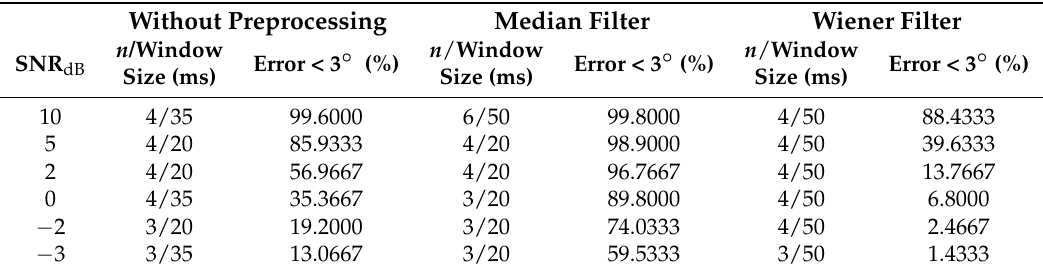
Table 2. Least squares (LS) method simulation: The best parameters per signal-to-noise ratio (SNR).